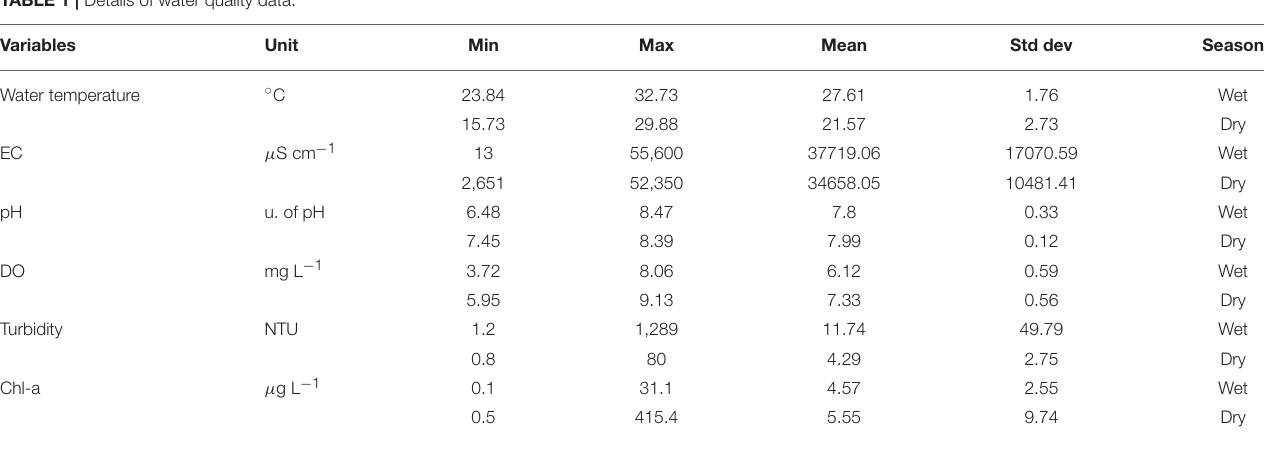
TABLE 1 | Details of water quality